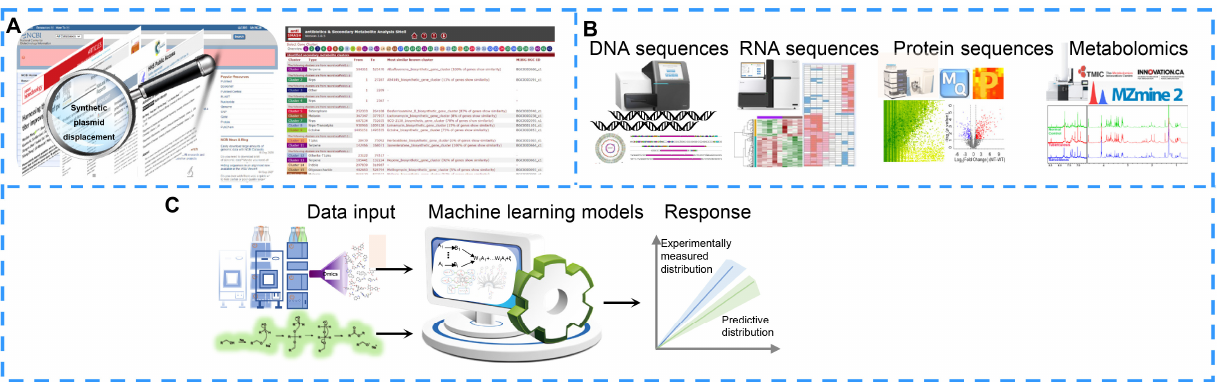
Figure 4. Bioinformatic analyses for natural product improvement. ( A ) Extracting the target information via online databases. ( B ) Discovering new natural products with the help of omics analyses. ( C ) Computer modeling predictions via metabolic networks.